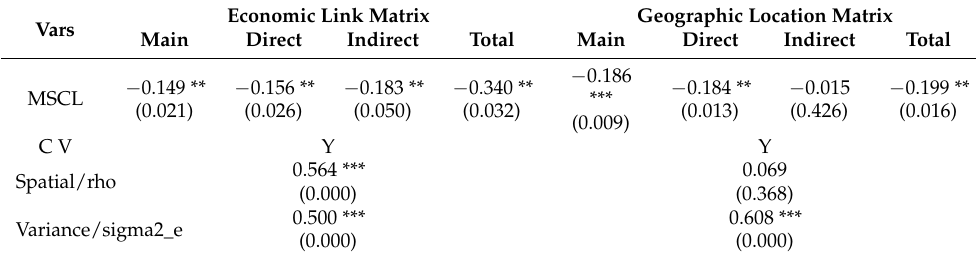
Table 7. Regression results of